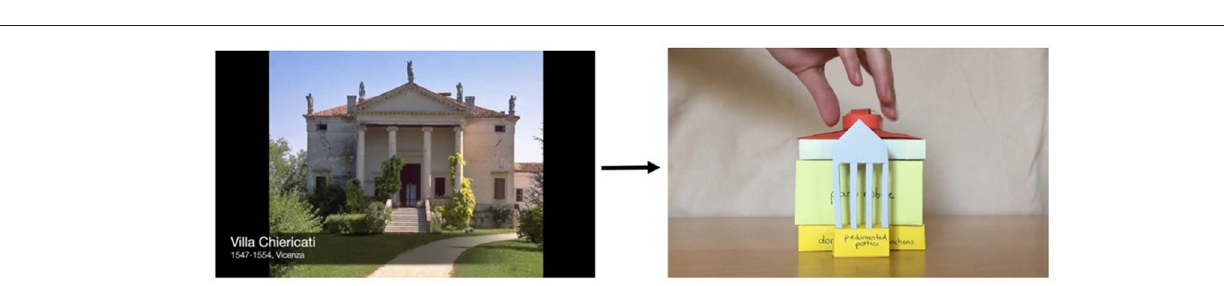
FIGURE 10 | Transducing an excerpt from an academic paper to Model 4.